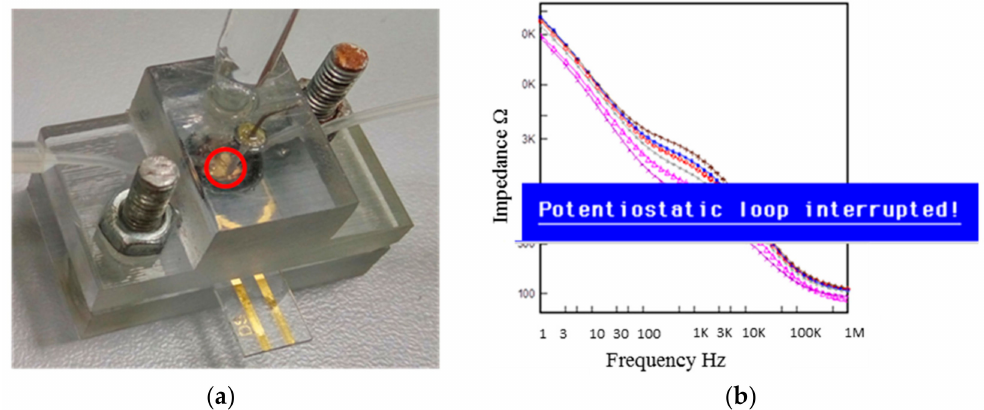
Figure 1. ( a ) Assembled microfluidic device with reference, counter and working electrodes. The bottom and top parts of the device were mounted via bolts and the working area was fixed using an o-ring. The inlet and outlet tubes were positioned at 45 ◦ from the sensing surface. The inlet tube was connected to the pumping system, which permitted the liquid flow at a specified flow rate. The red circle encloses the area where air bubbles formed during the course of the experiment. ( b ) Error message obtained during impedance measurement: “Potentiostatic loop interrupted.” In the background, typical data for impedance vs. frequency measurement after protein